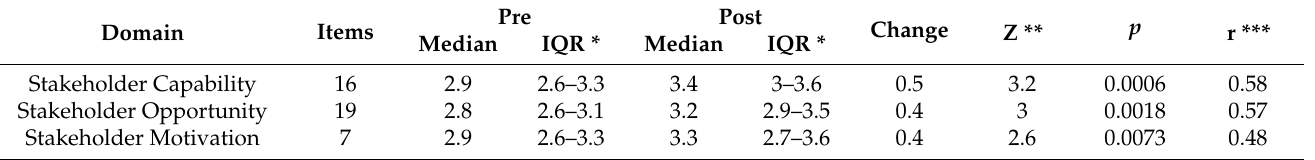
Table 3. Descriptive statistics and results from the Wilcoxon Signed Rank tests for changes in stakeholder physical activity